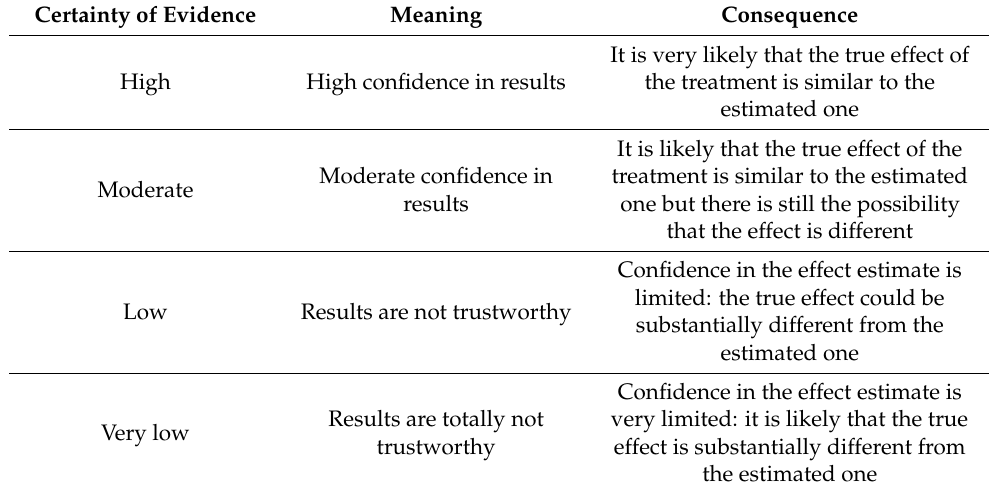
Table 1. Grading of certainty of evidence.